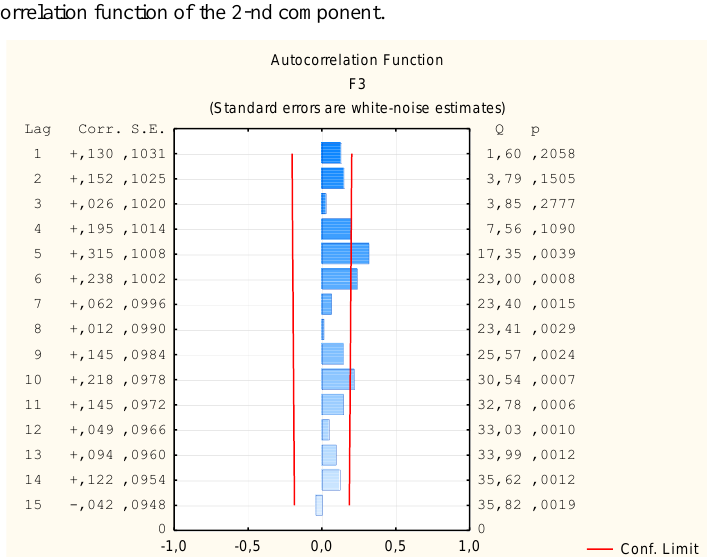
Fig. 12. Autocorrelation function of the 3-rd